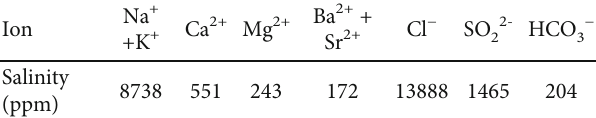
Table 3: Ionic components of connate